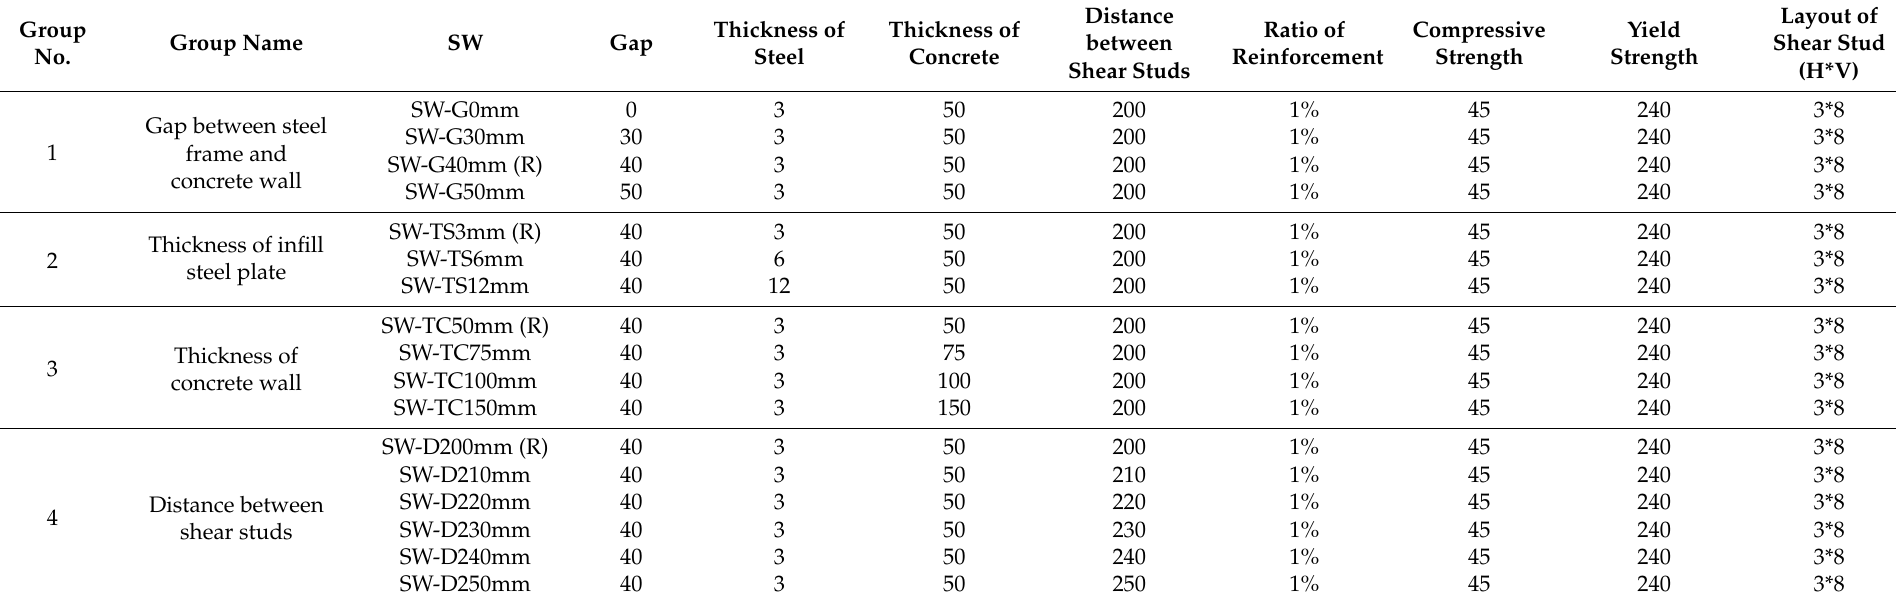
Table 1. Details of the experimental specimens and their mechanical